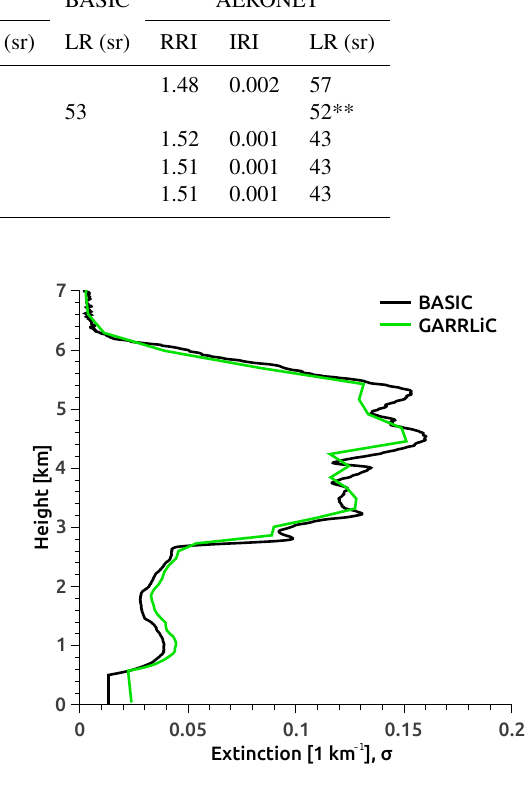
Figure 5. Aerosol extinction profiles at a wavelength 532nm re- trieved by the GARRLiC (green) and the BASIC (black) algorithms for dust event over Lille on 30 March